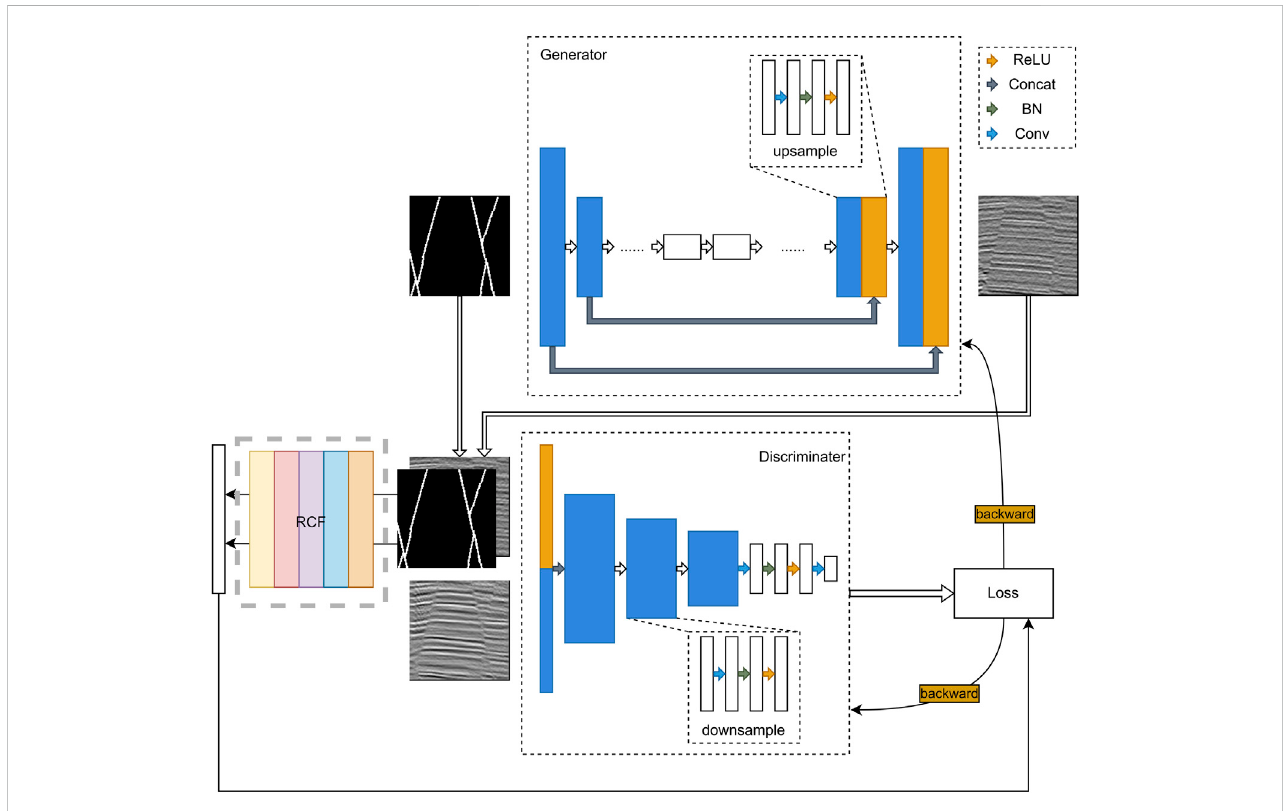
FIGURE 2 Architecture of Fault2SeisGAN. Weinput the fault location labels and corresponding generated data into the RCF detector R. By using theedge detector R, we obtained different levels of pixel-level edge detection effects.